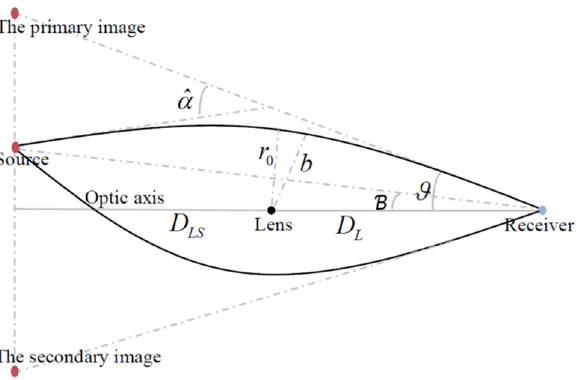
Fig. 3 The schematic diagram of light bending and